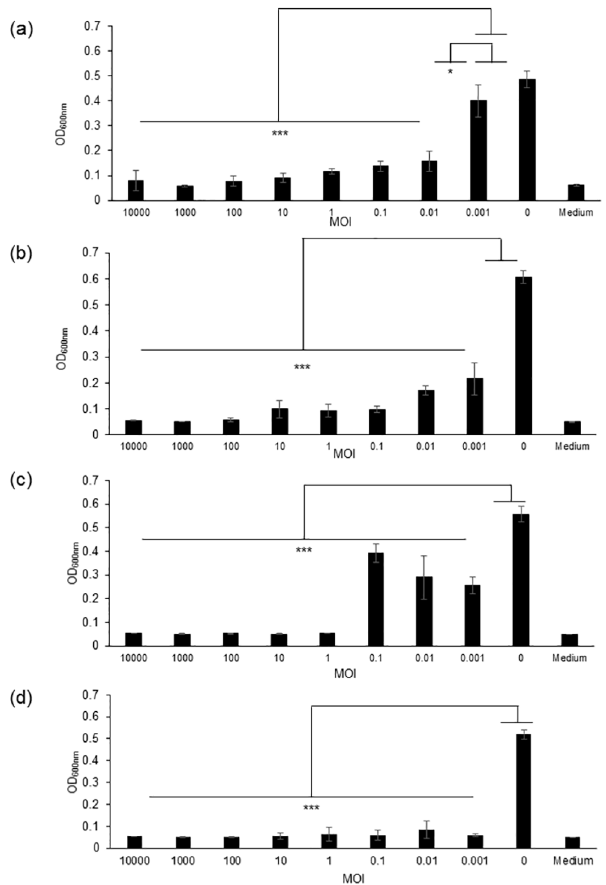
Fig 4. Bacterial challenge test. The optical density (OD 600nm ) was measured after 24 h of contact between E . coli strain DPC6051 and phage ɸ APCEc01 (a), phage ɸ APCEc02 (b), phage ɸ APCEc03 (c), and a cocktail of the three phages (d). *** p < 0.001, * p <